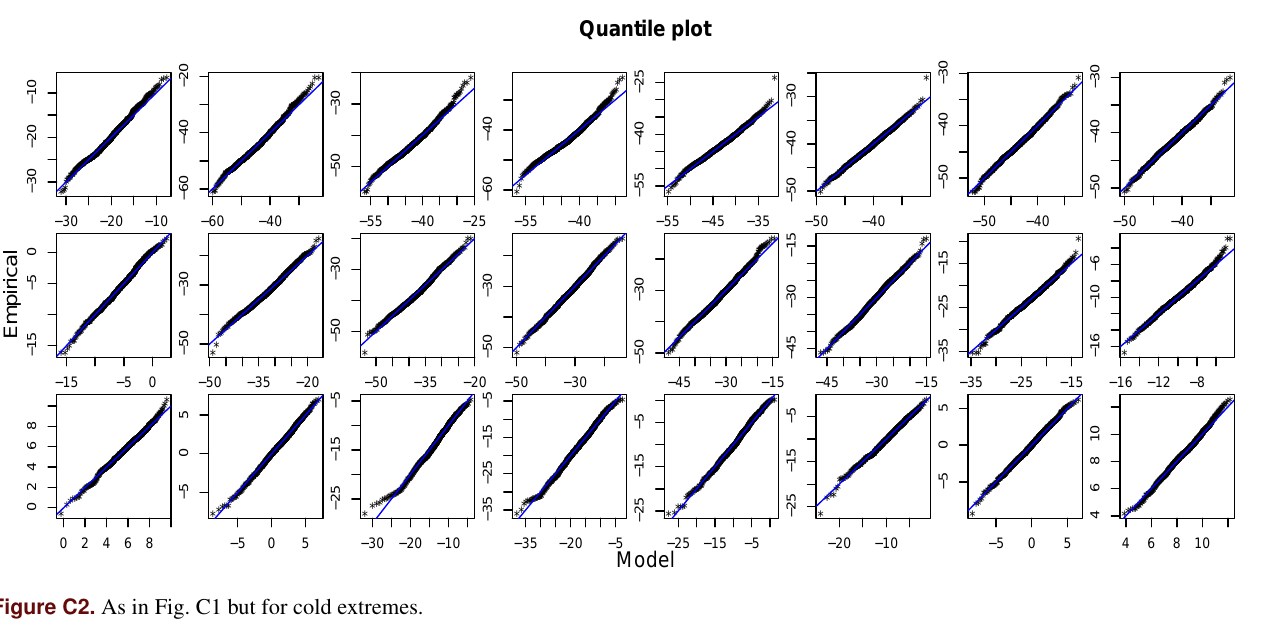
Figure C2. As in Fig. C1 but for cold